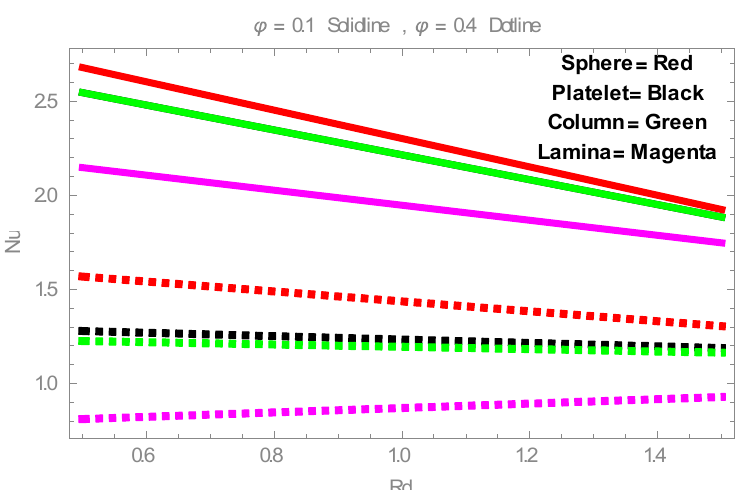
Figure 11. Nu for dissimilar values of M.